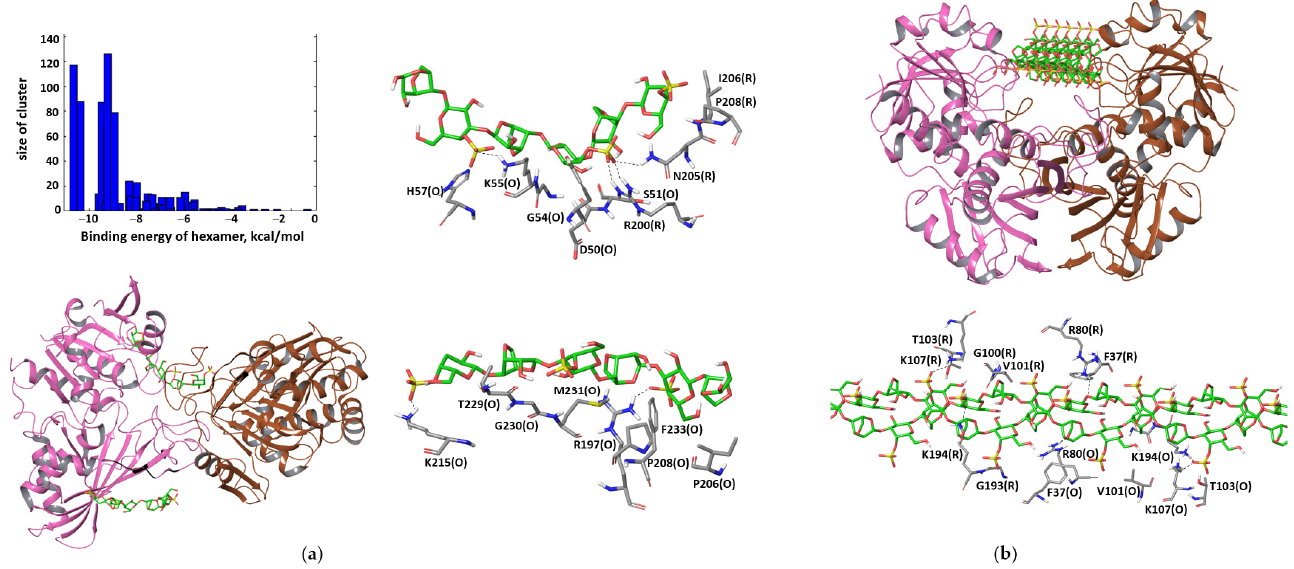
Figure 7. Docking poses of flexible κ‐ carrageenan chain in OR ‐ dimer that may prevent tetramer formation ( a ). The most favorable binding pose of κ‐ carrageenan double helix in the OR dimer ( b ).